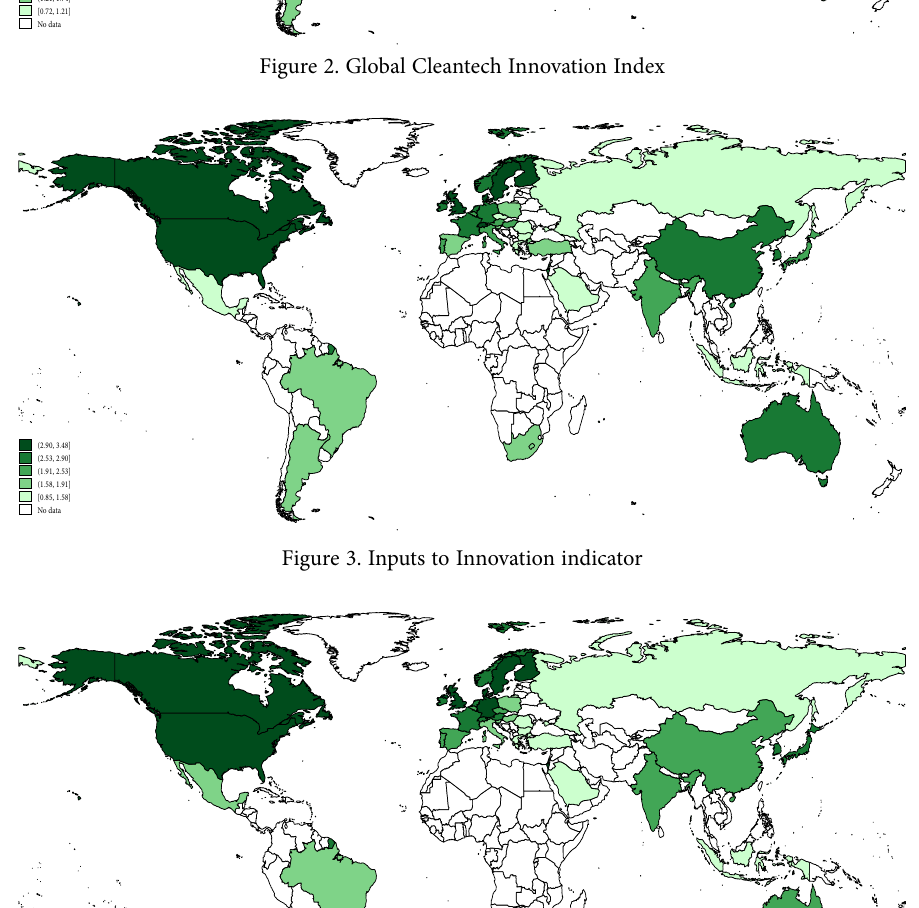
Figure 2. Global Cleantech Innovation Index